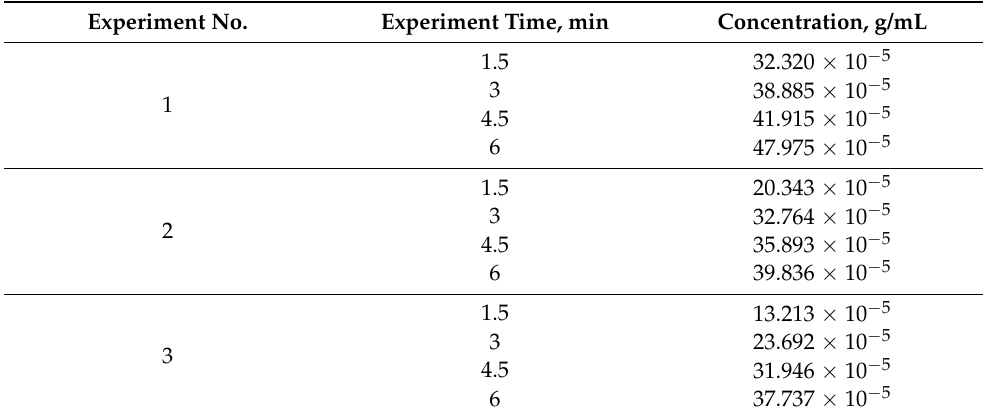
Table 1. Experimental data on the melatonin release from chitosan-based aerogel particles. Experiment